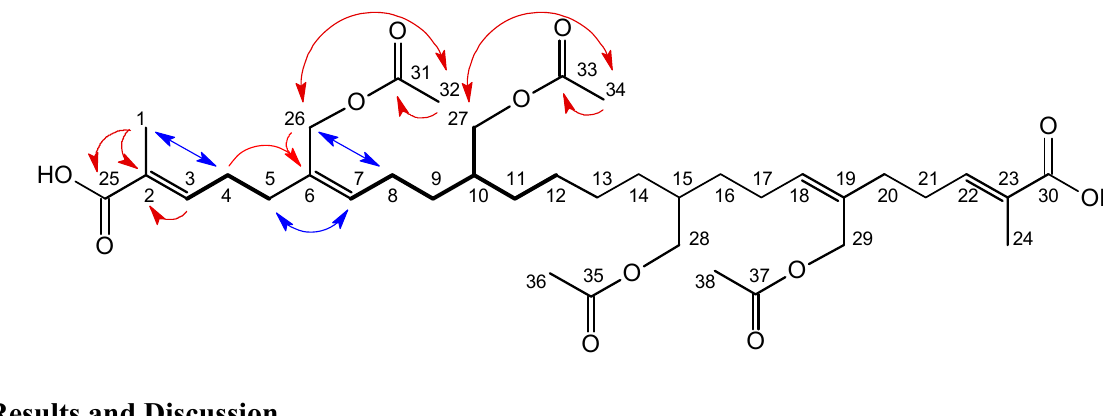
Figure 1. 25,30-dicarboxy-26,27,28,29-tetraacetoxy-10,11,14,15-tetrahydrosqualene ( 1 ) from Protium subserratum young leaf tissue. Scalar coupling networks (bold bonds) and pertinent HMBC and NOESY correlations (red and blue arrows respectively) are indicated for one mirror half of the